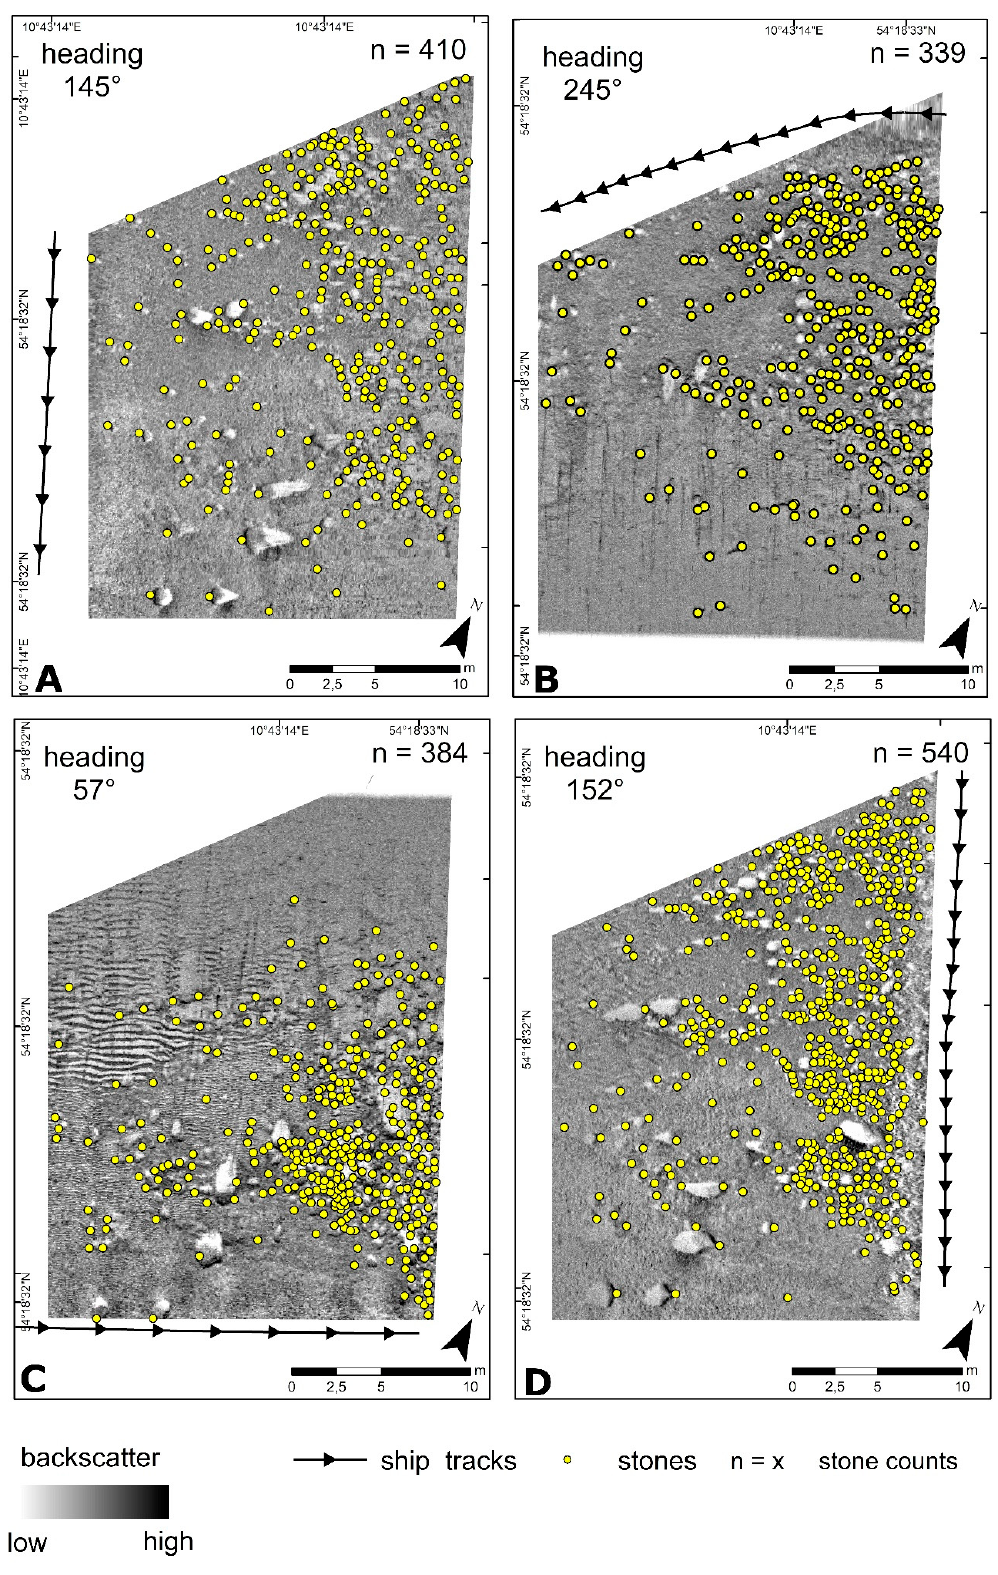
Figure 5. Medium-resolution SSS images of the study area. Yellow dots represent detected boulders. ( A – D ) The four images are generated with four different approach positions and angles.